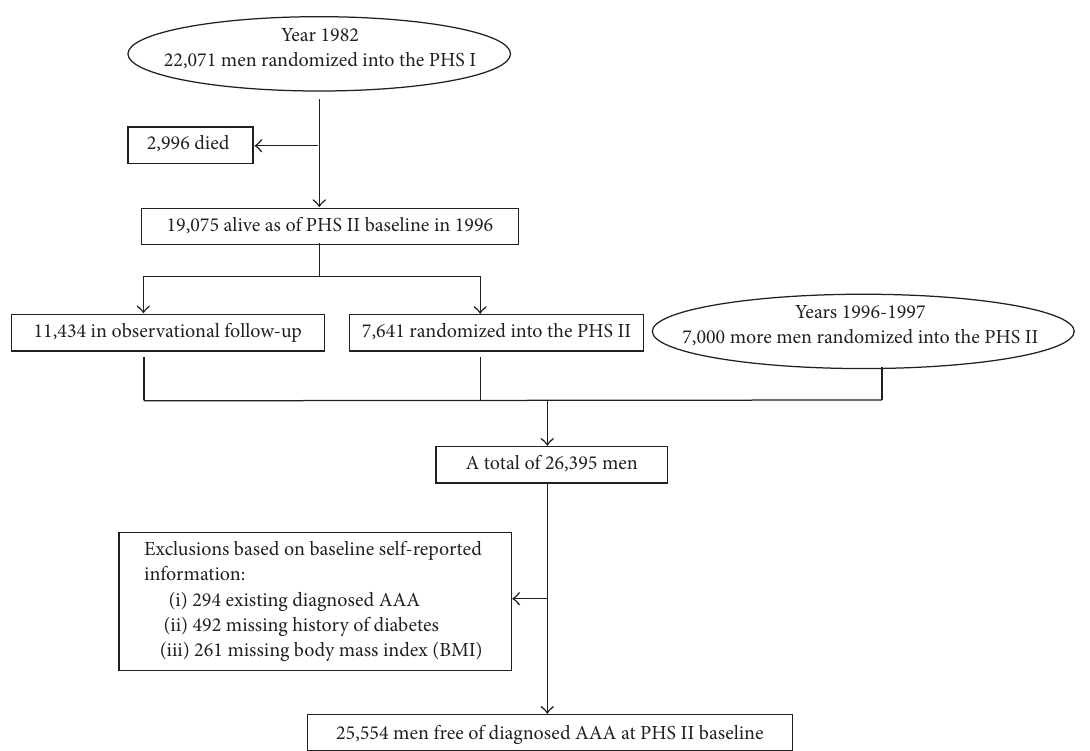
Figure 1: Flow diagram of participants in the Physicians’ Health Study (PHS) I and II that are included in the current